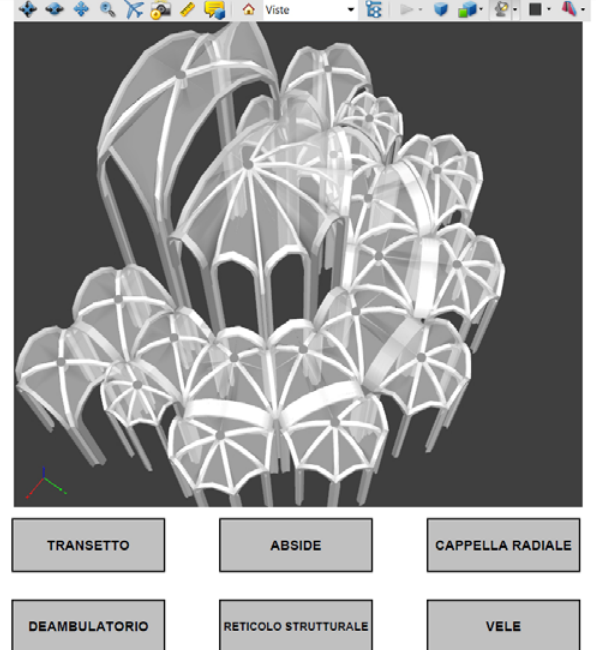
Figure 14 . Naples S. Lorenzo Maggiore. 3D PDF: testing layering tools